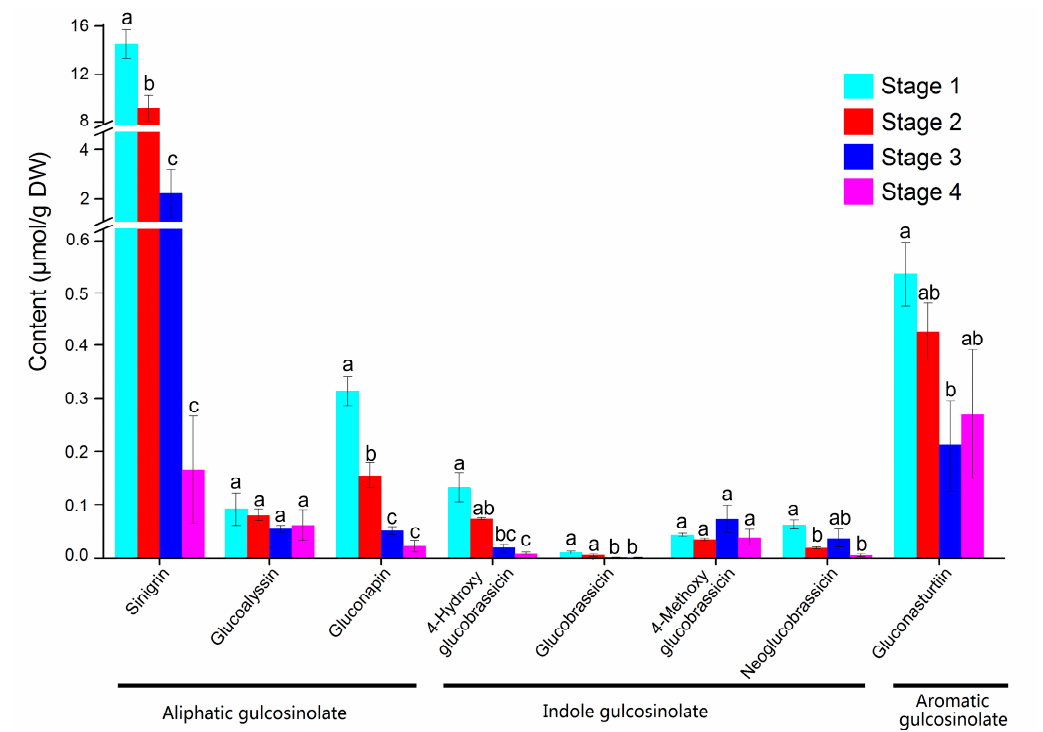
Figure 9. The composition and content of glucosinolates (GLSs) in different stages in stem mustard. For each tissue, the same letter in the same testing method means no significant differences ( p < 0.05) according to the Least Significant Differences (LSD) test and Tukey tests.